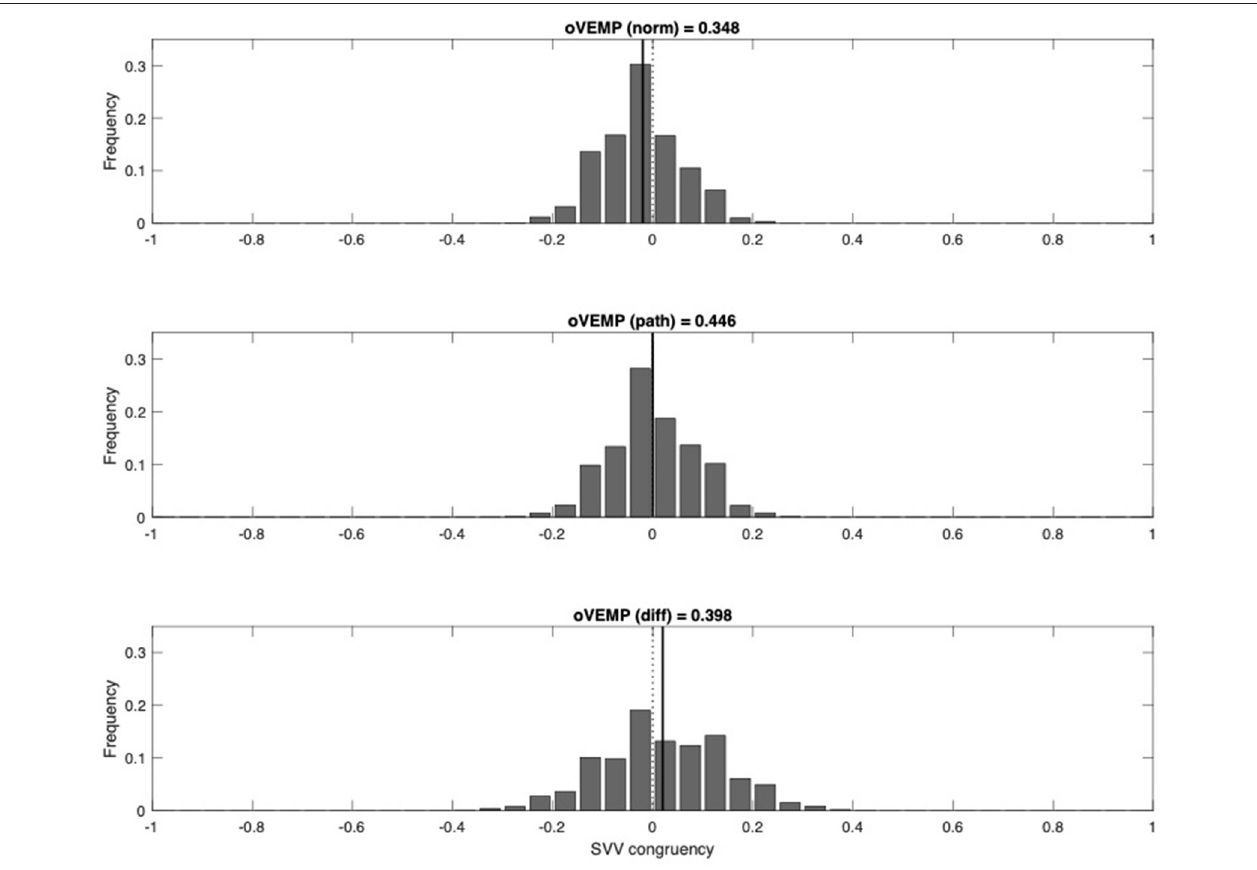
FIGURE 3 | Congruency between oVEMP and SVV (upper panel, patients with normal oVEMP; middle panel, patients with asymmetric oVEMP; lower panel, difference). Groups of patients are age-matched. For each patient, a congruency value for SVV was assigned. Congruency value in patients with normal oVEMP: 0, SVV normal; 1, SVV tilted to the right; − 1, SVV tilted to the left. Congruency value in patients with asymmetric oVEMP: 0, SVV normal; 1, SVV congruent with oVEMP asymmetry; − 1, SVV not congruent with oVEMP asymmetry. Frequency distributions of means were obtained by bootstrapping. oVEMP, ocular vestibular evoked myogenic potential; SVV, subjective visual